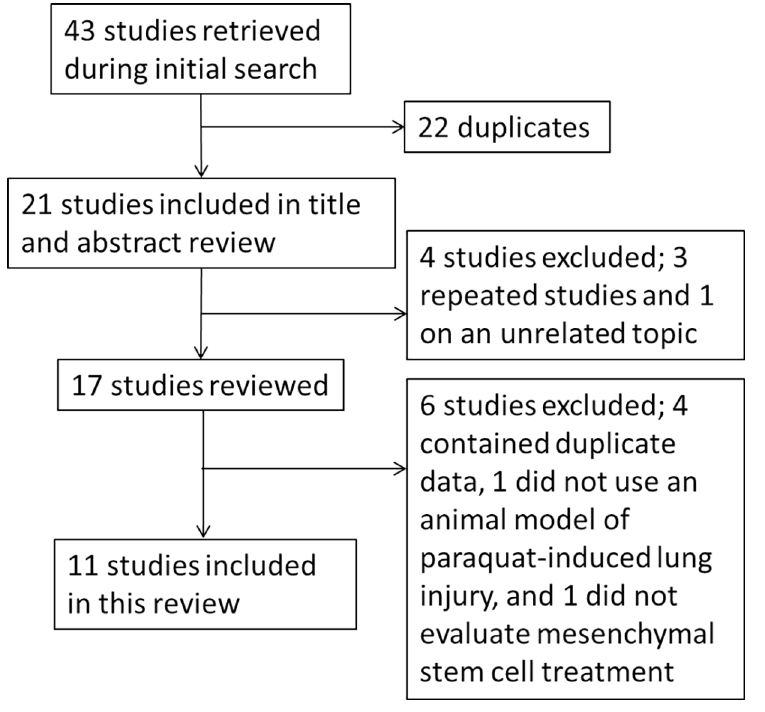
Fig 1. Included and excluded